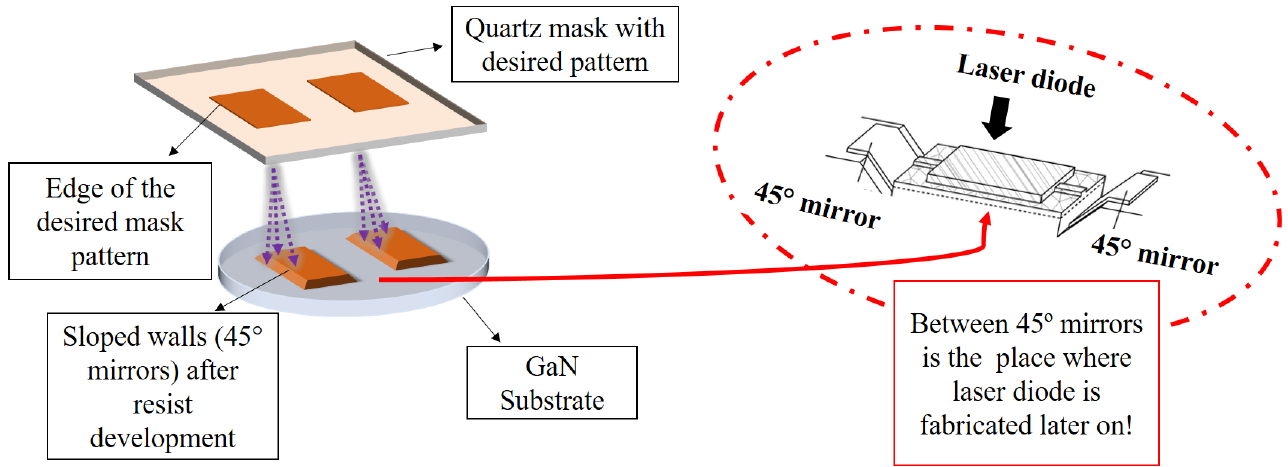
Figure 4. Photolithography for patterning of GaN substrate through mask-aligner system. Quartz mask indicates the edge of the desired pattern at which shadow appears during the exposure and spreads when the distance between the mask and the surface varies accordingly. The distance between the photomask and wafer is retained at 40–60 µm.